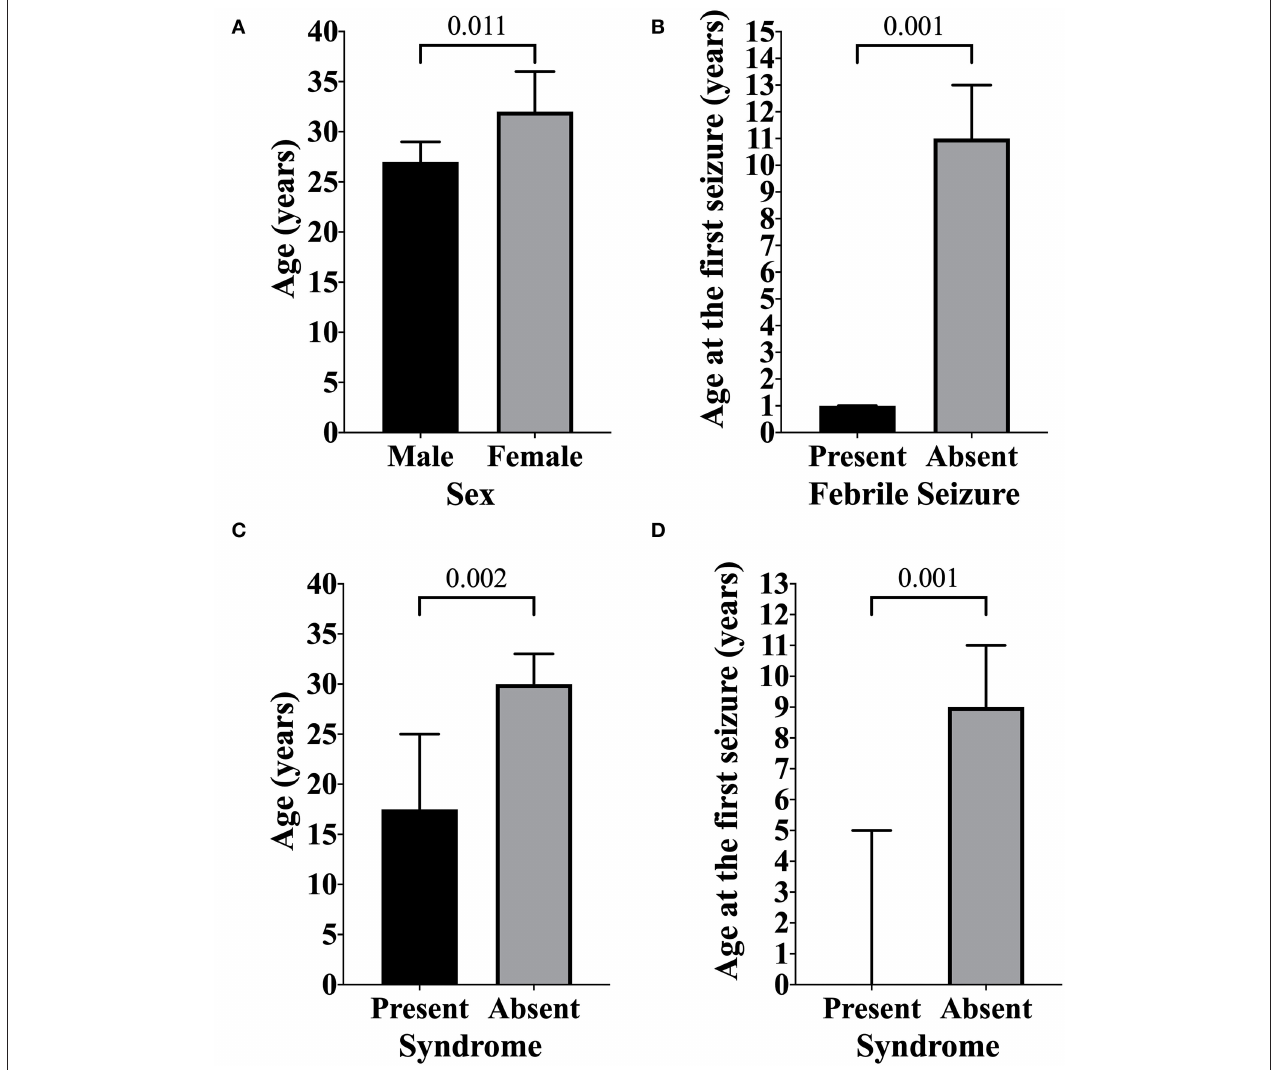
FIGURE 1 | Overview of the significant association between age and sex, genetic syndrome, and first seizure. (A) Significant statistical data were observed when age was compared with sex (male 27 years; female 32 years; p = 0.011), indicating that men present seizures earlier than women. (B) Childhood febrile seizure was present at the age of the first seizure at ages between 0 and 2 (1 year; p < 0.001). In addition, the age at first seizure in patients without febrile seizures was 11 years. (C) Patients with any genetic syndrome presented seizures earlier (17.5 vs. 30 years; p = 0.002). (D) Age at the first seizure in patients with genetic syndromes ranged between 0 and 7 years (present < 1 year; absent 9 years; p < 0.001). The data are shown as median and 95% confidence interval (CI). The statistical analyses were done using the Mann–Whitney test. An alpha of 0.05 was adopted in all